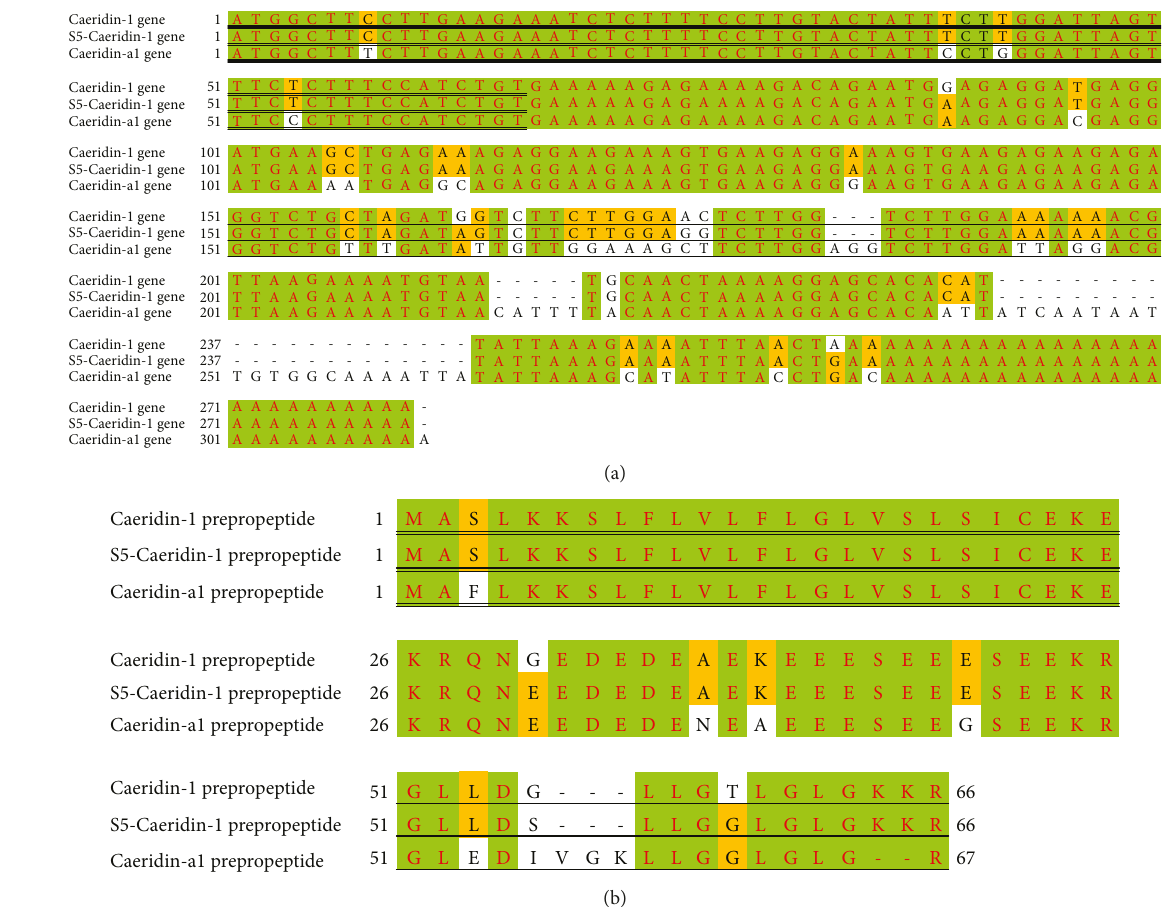
Figure 2: Alignments of (a) nucleotide sequences of cloned preprocaeridin cDNAs and (b) translated preprocaeridin open-reading frames established MEGA6. The identical and conservative regions are highlighted in green and yellow, respectively. Putative signal peptide sequences encoding regions and putative signal peptide sequences are double-underlined, and mature Caeridin sequences encoding regions and mature Caeridins are single-underlined.